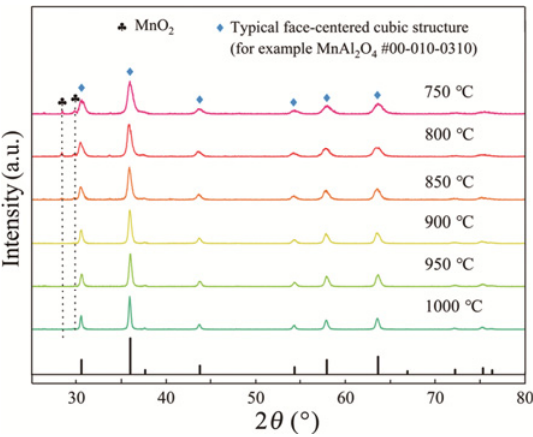
Fig. 1 XRD patterns of samples synthesized at 750– 1000 . ℃